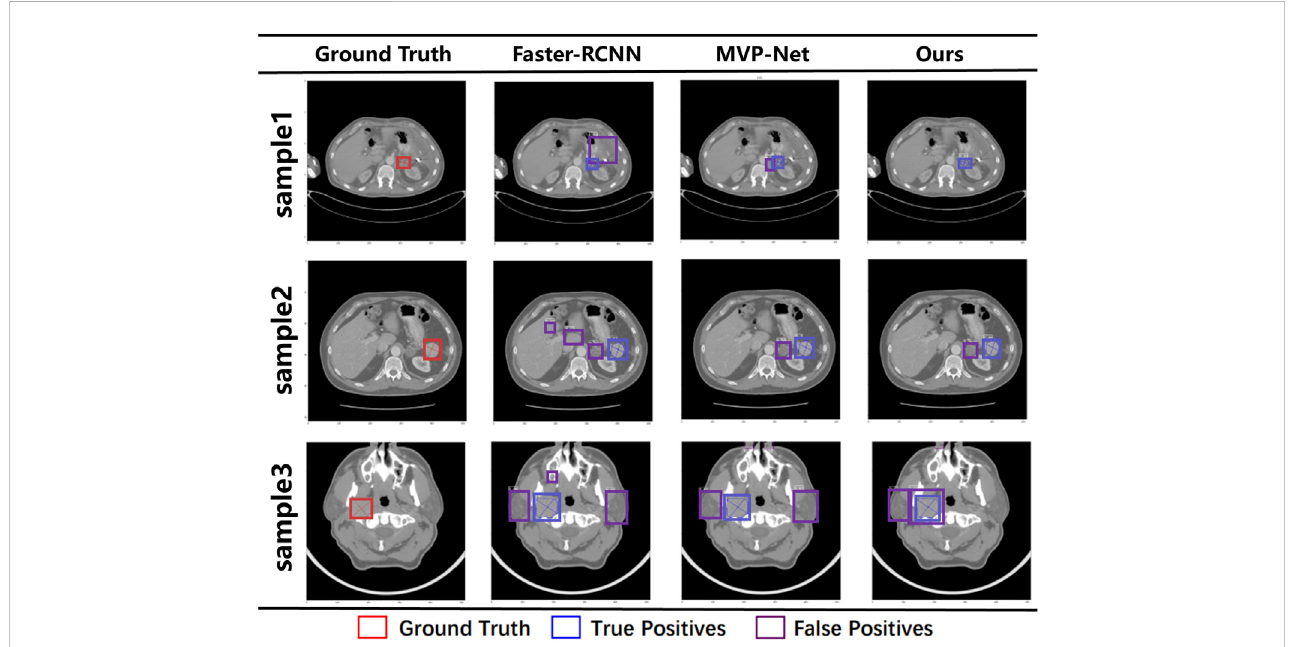
FIGURE 5 Visualizationresultsunderdifferentmodels.Theredboxrepresentsthegroundtruth,theblueboxrepresentstruepositive,andthepurpleboxrepresents false positive.